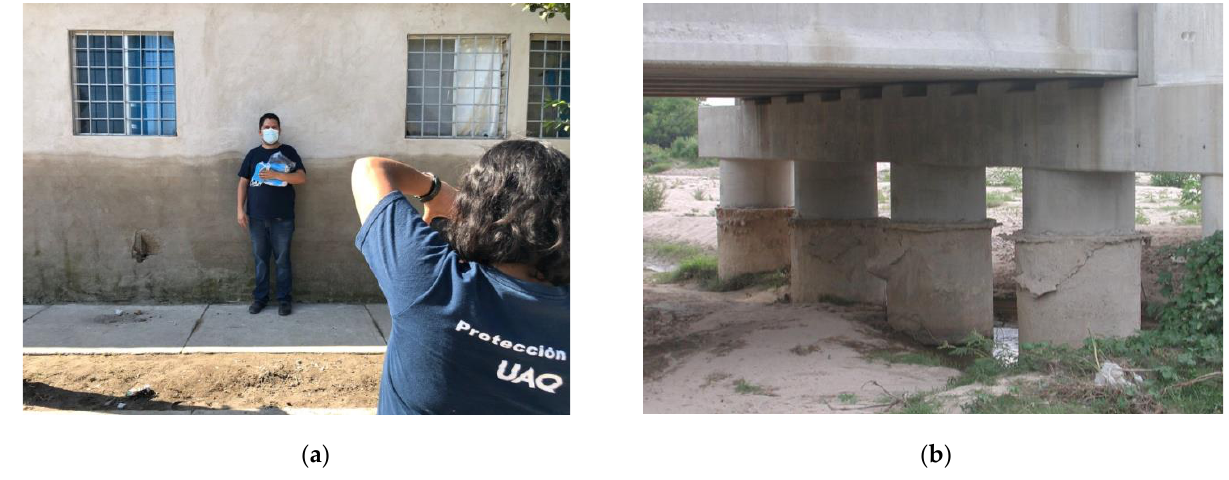
Figure 4. Evidence of traces. ( a ) Water marks on the wall of houses; ( b ) sediment marks on bridge piles.